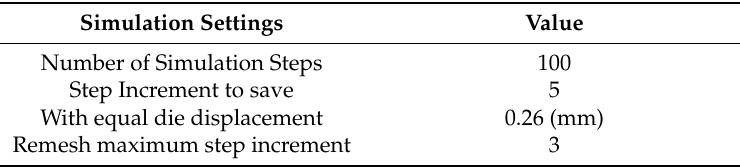
Table 1. General simulation settings.